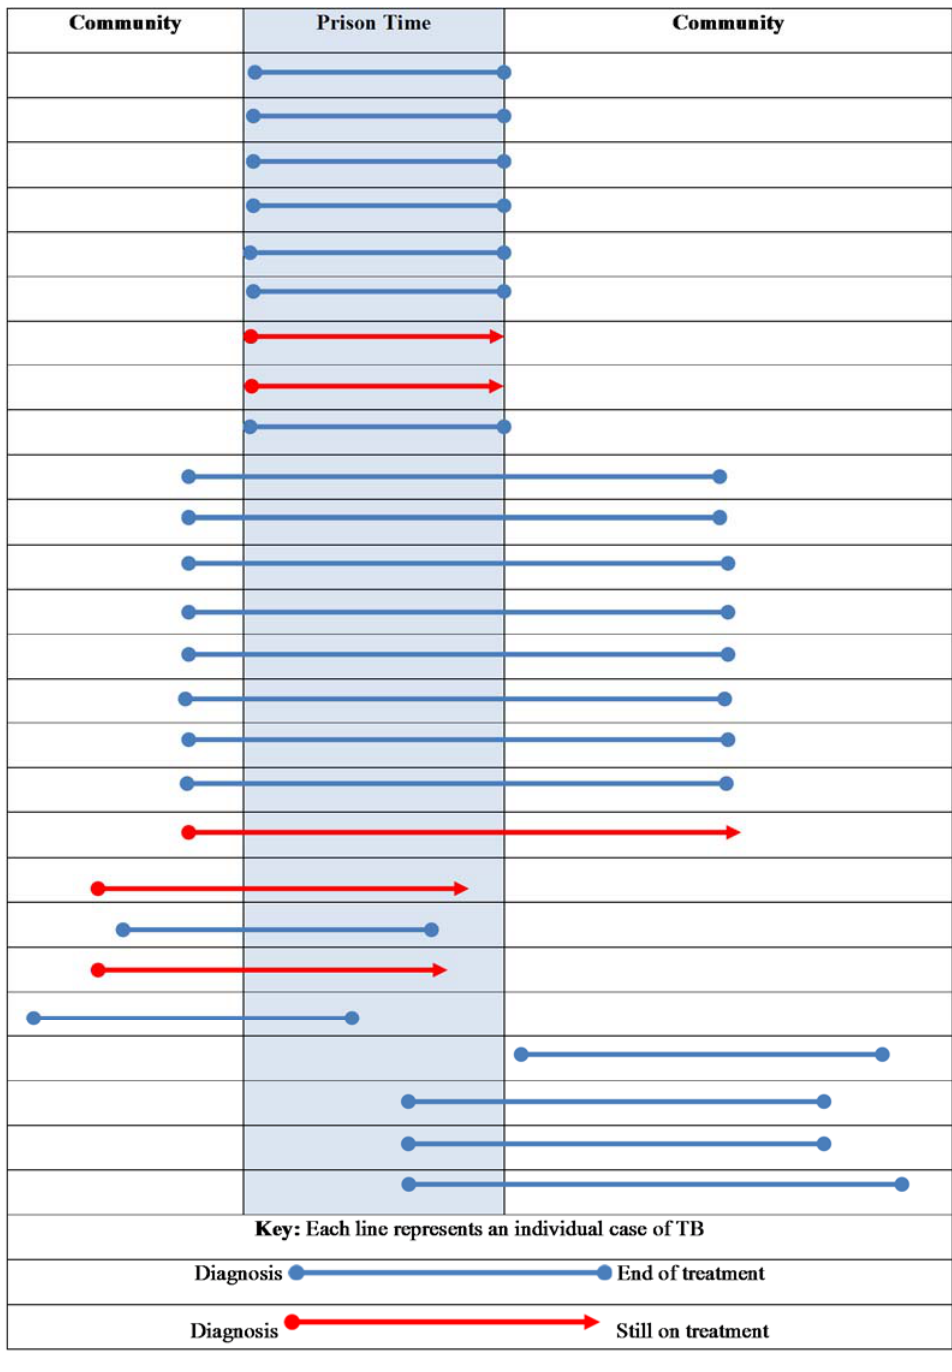
Figure 1. The relationship between incarceration in correctional facilities and tuberculosis diagnosis and treatment. and